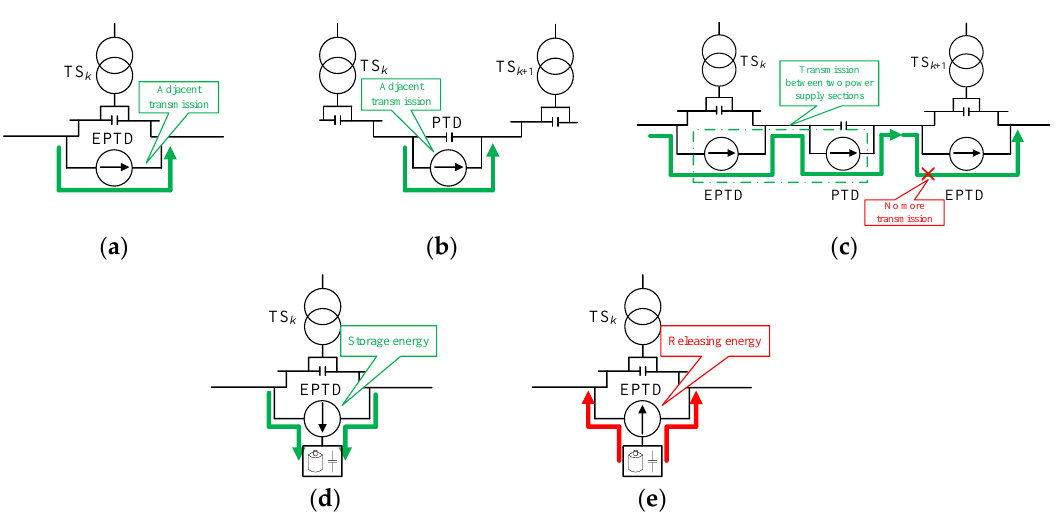
Figure 10. Control algorithm principle: ( a ) adjacent transmission; ( b ) adjacent transmission; ( c ) Figure 10. transmission between two power supply sections; ( d ) storage energy; and ( e ) release energy.